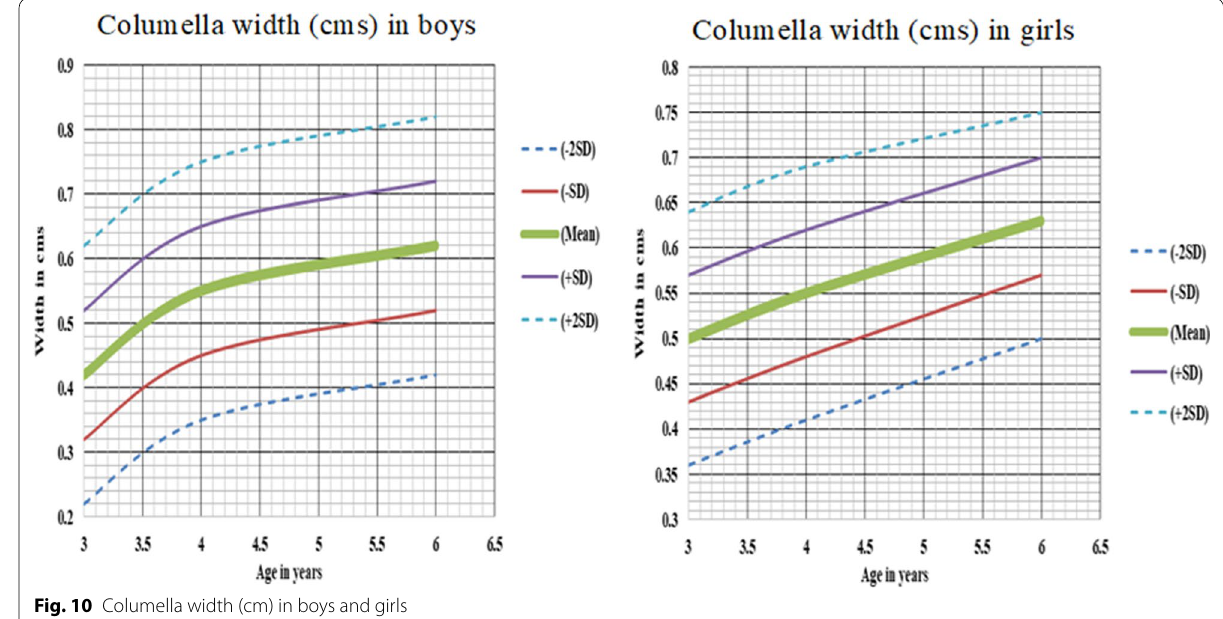
2.7 to 2.8 cm, from 7.7 to 8.1 cm and from 4.9 to 5.3 cm, respectively, with no significant difference between males and females with p -value > 0.05 [18]. Osunwoke et al., similarly found that the mean of inner canthal distance (ICD), outer canthal distance (ICD), and inter- pupillary distance (IPD) of another study on Nigerian children ranged from 2.3 to 2.5 cm, from 7.9 to 8.6 cm